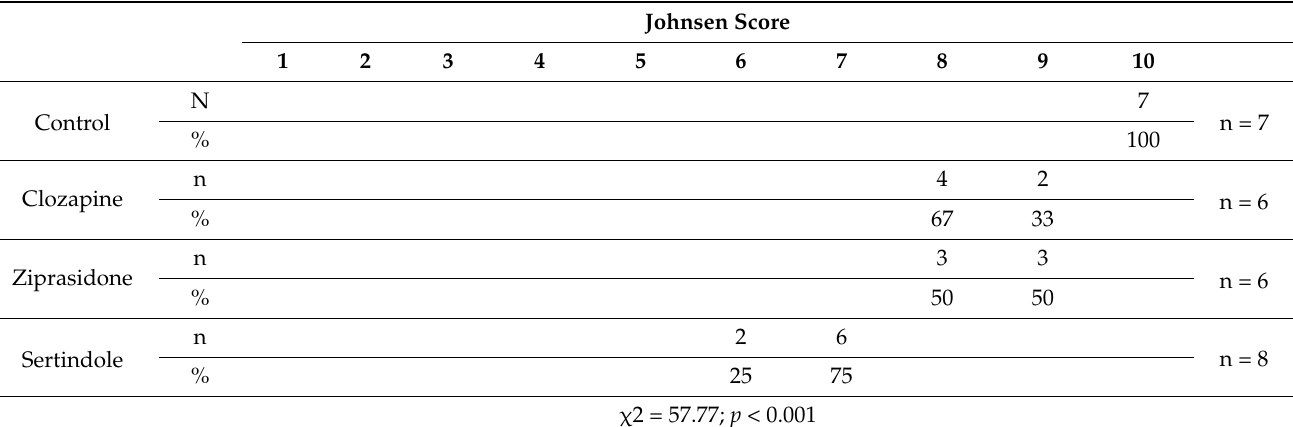
Table 2. Johnsen score in rat testicles after 4-weeks of treatment with APDs. Effects of treatments were tested by Pearson’s chi-squared